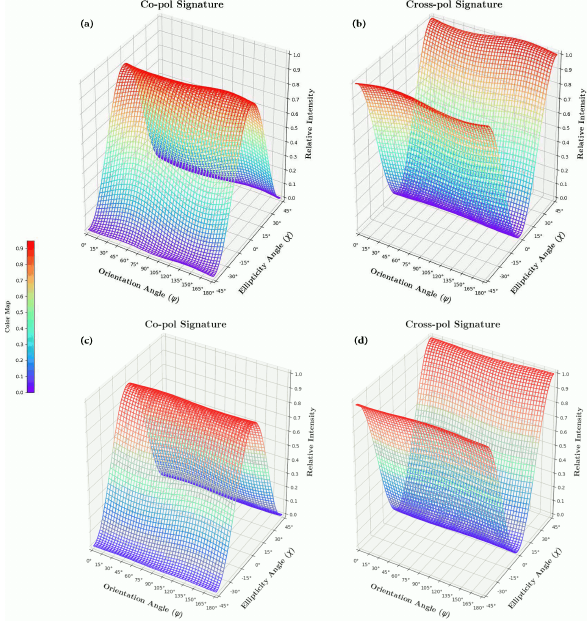
Figure 3. Polarimetric signatires of CR23. (a) , (c) Copolar Polarimetric signatures before and after the calibrabtion respectively. (b) , (d) Crosspolar Polarimetric signatures before and after the calibrabtion respectively